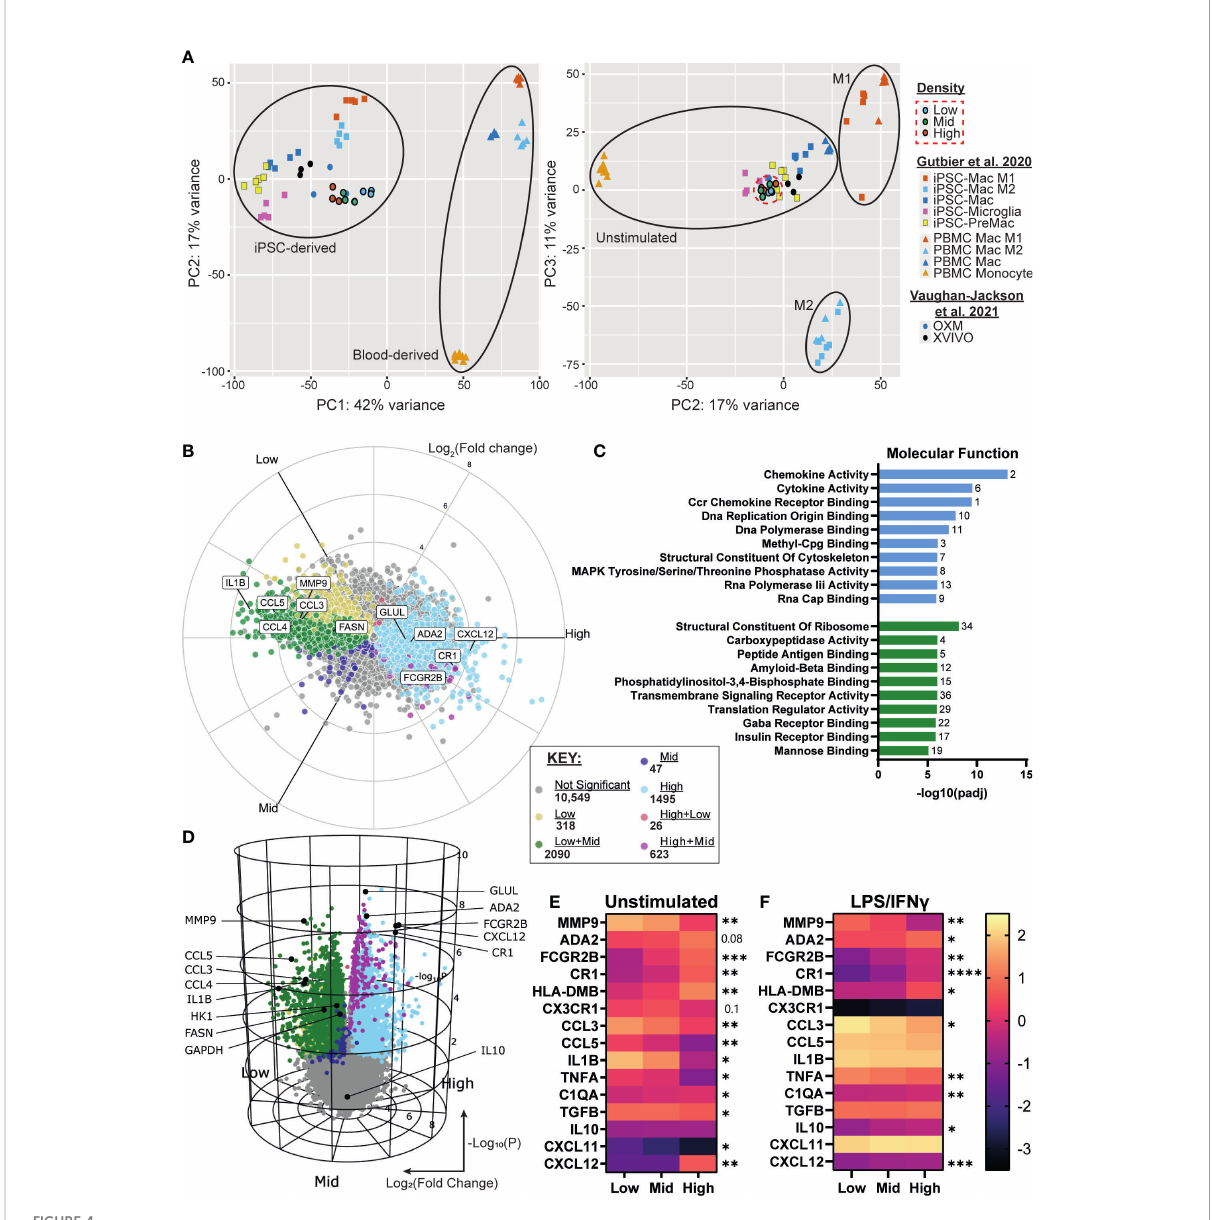
FIGURE 4 iPSC-Macs show differences in transcription at different plating densities, with low density driving a pro-in fl ammatory signature and high density favoring phagocytosis. (A) PCA comparison of different density iPSC-Macs (SFC840-03-03 iPSC line) compared to OXM or XVIVO-15 cultured iPSC-Mac (1.04x10 5 cells/cm 2 ) (35) and iPSC-Macs, microglia, MDM and M1 or M2 polarized iPSC-Mac and MDM (1.5x10 5 cells/cm 2 ) (43) (B, C) Differential gene expression between densities, x axis Log 2 (Fold change), y axis Log 10 (P value). (D) Molecular function GO terms enriched in high (green) and low (blue) density iPSC-Macs. (E, F) qPCR of top differential gene expression hits and cytokines identi fi ed in fi gure 1 in a 2 nd iPSC line (SFC841-03-01) (E) unstimulated, or (F) polarized. Scale shows Log 10 (2 - D Ct ), signi fi cance indicated for low vs high comparison, n=4 two-way ANOVA, Tukey ’ s multiple comparisons test with Greenhouse-Geisser correction. Signi fi cance is de fi ned as * <0.05, ** <0.01, ***<0.001,